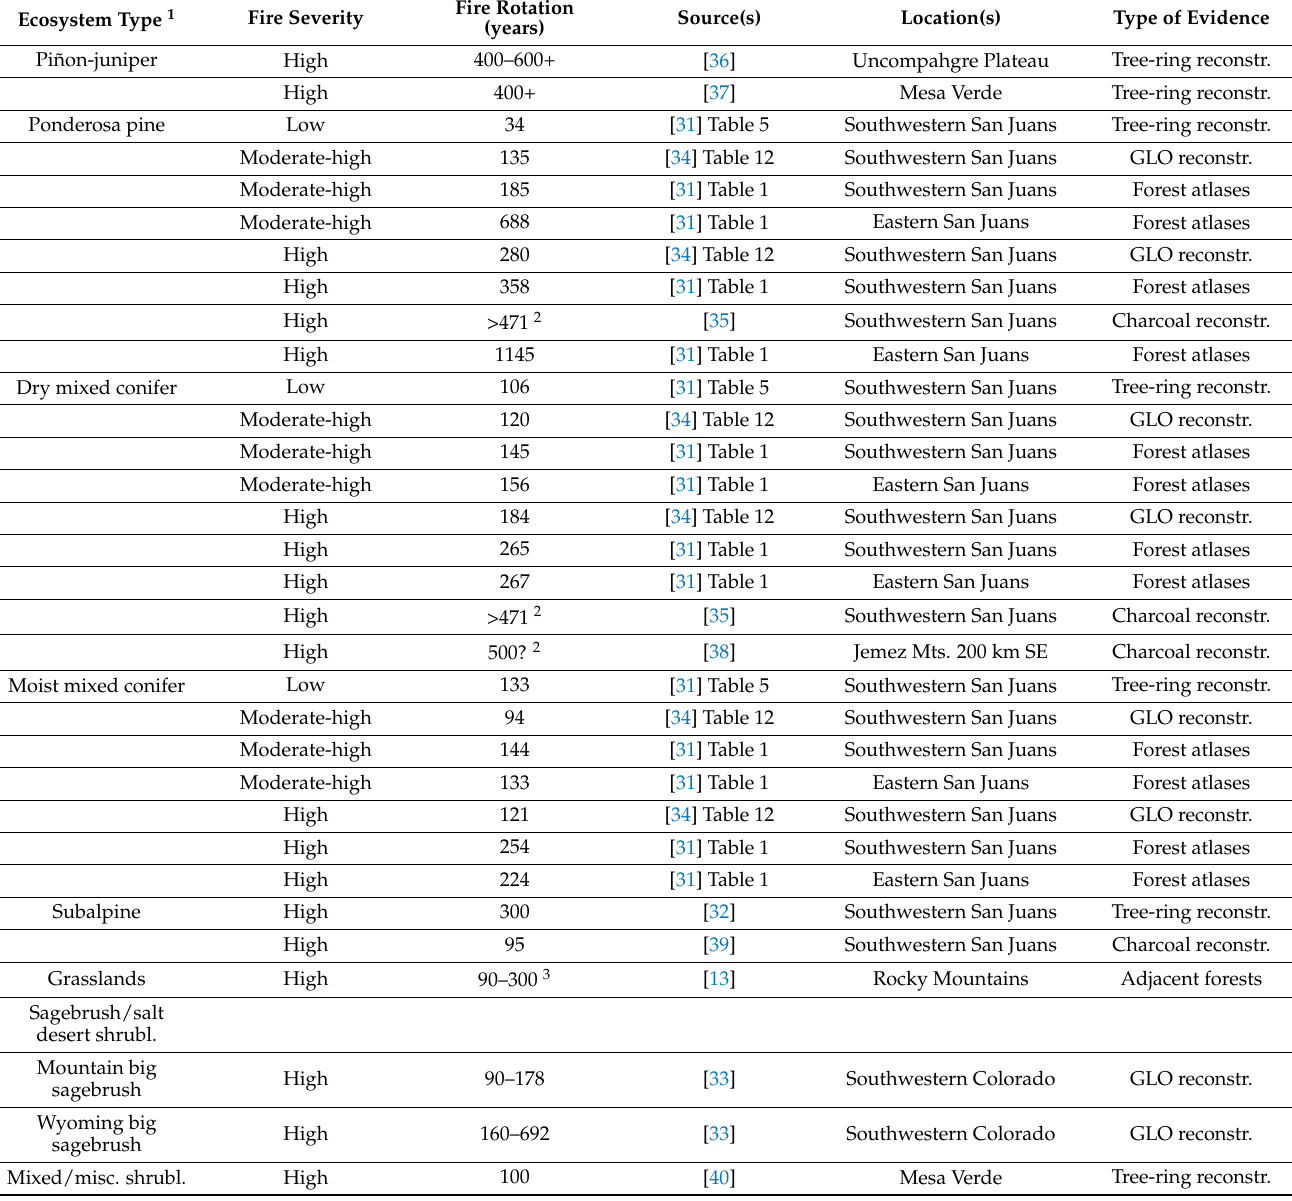
Table 6. Historical fire rotations in and near the San Juan Mountains by ecosystem type and fire